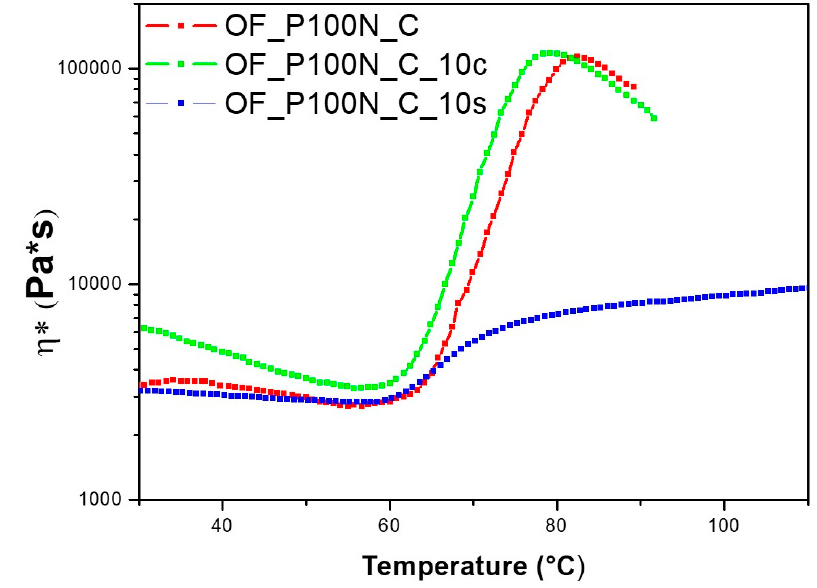
Figure 2. Rheological dynamic curves of the OF_P100N_C samples in the presence and absence of additives: Viscosity ( η ) as a function of temperature (T).